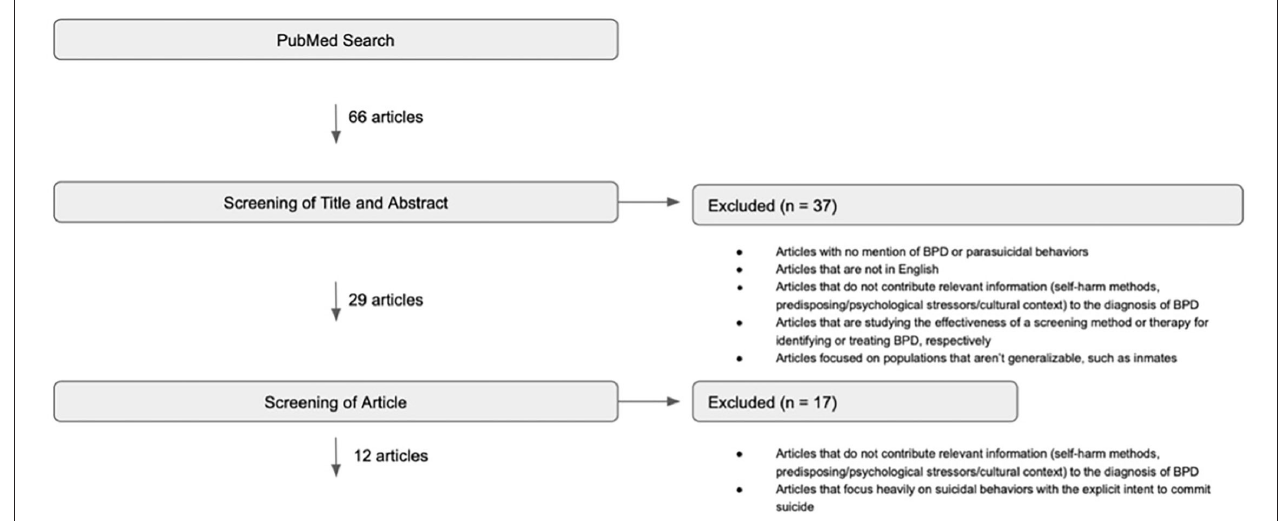
FIGURE 1 | PubMed search for articles pertaining to Borderline Personality Disorder presentations (3/2020).